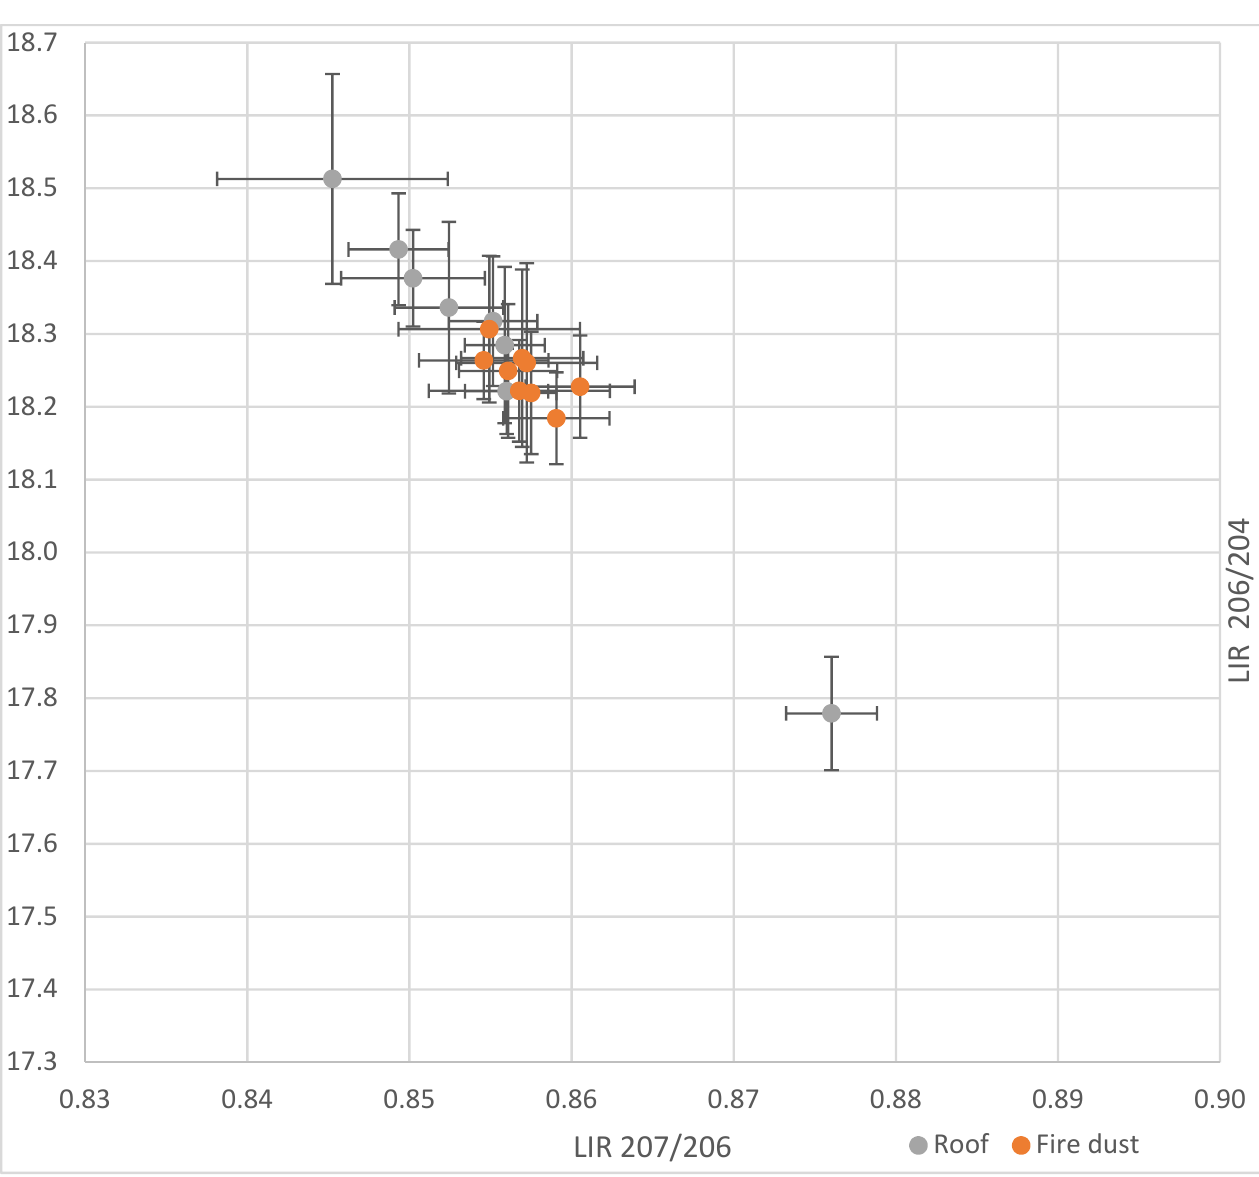
Figure 2. Lead isotopic ratios of Notre Dame de Paris cathedral roof and of dust from its fire. Figure 3 shows lead isotopic ratios for cathedral fire dust and home dust in France. It indicates that the fire dust IR, with uncertainties, overlaps with many dust lead IRs measured in the homes of young children living in France in 2008–2009, under similar sampling and IR determination conditions